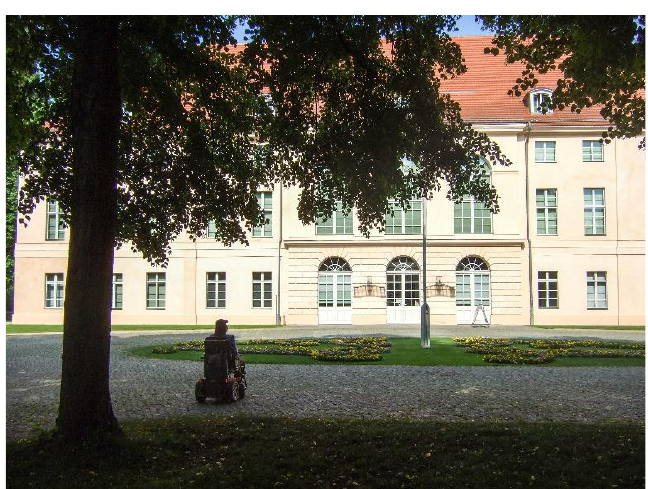
Figure 6. Schlosspark. Figure 6.